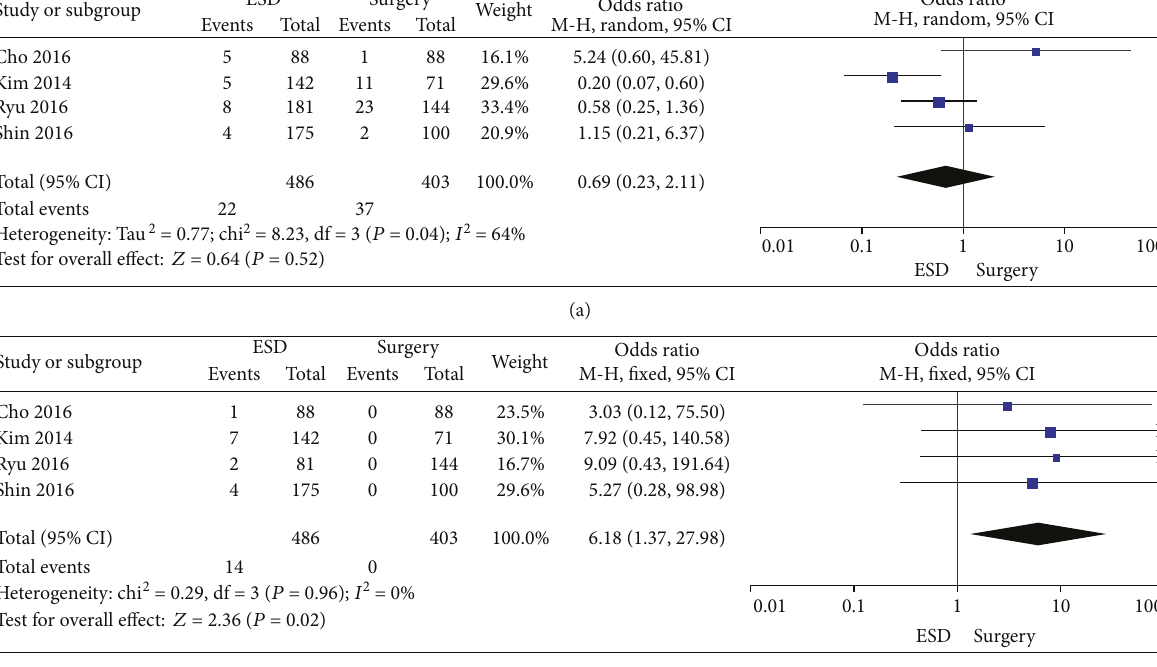
Figure 2: Forest plots showing the results of meta-analysis comparing the prevalence of bleeding and perforation between patients with ESD and surgery. (a) Comparing the prevalence of bleeding between ESD and surgery. (b) Comparing the prevalence of perforation between ESD and surgery. ESD: endoscopic submucosal